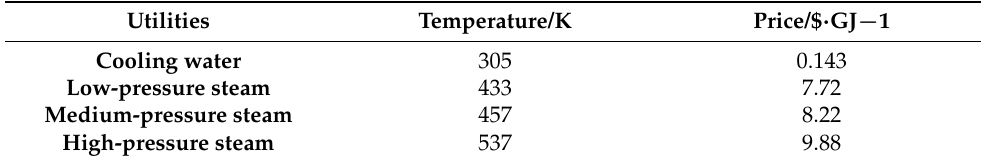
Table A4. Data of